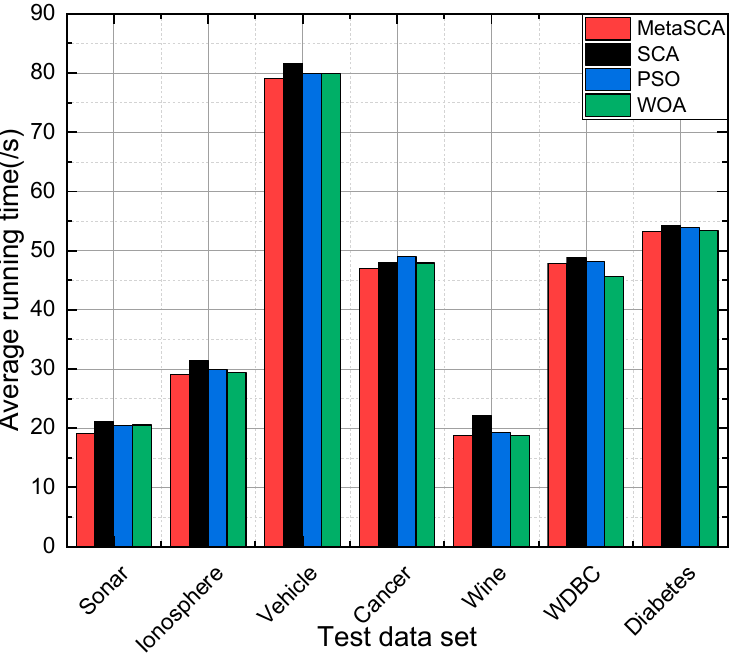
Figure 6. Average running time of the algorithms.